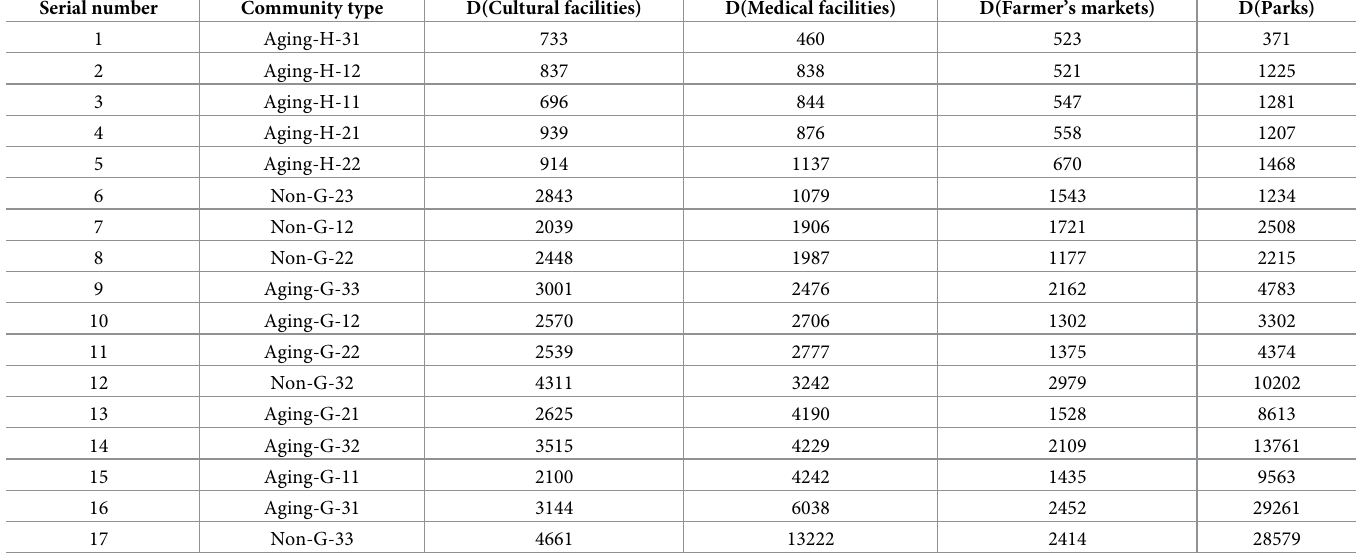
Table 5. The mean values of the accessibility of different types of